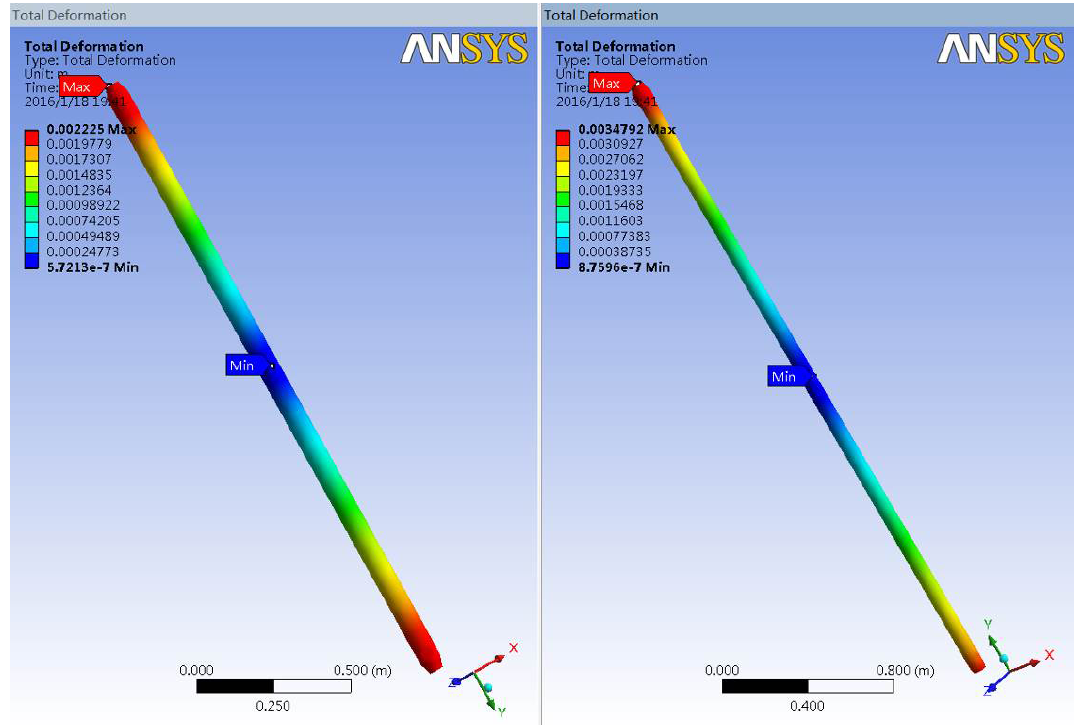
Figure 21. The total deformation nephogram comparison: the left picture shows the pressure field total deformation nephogram; the right picture shows the pressure field and temperature field coupling total deformation